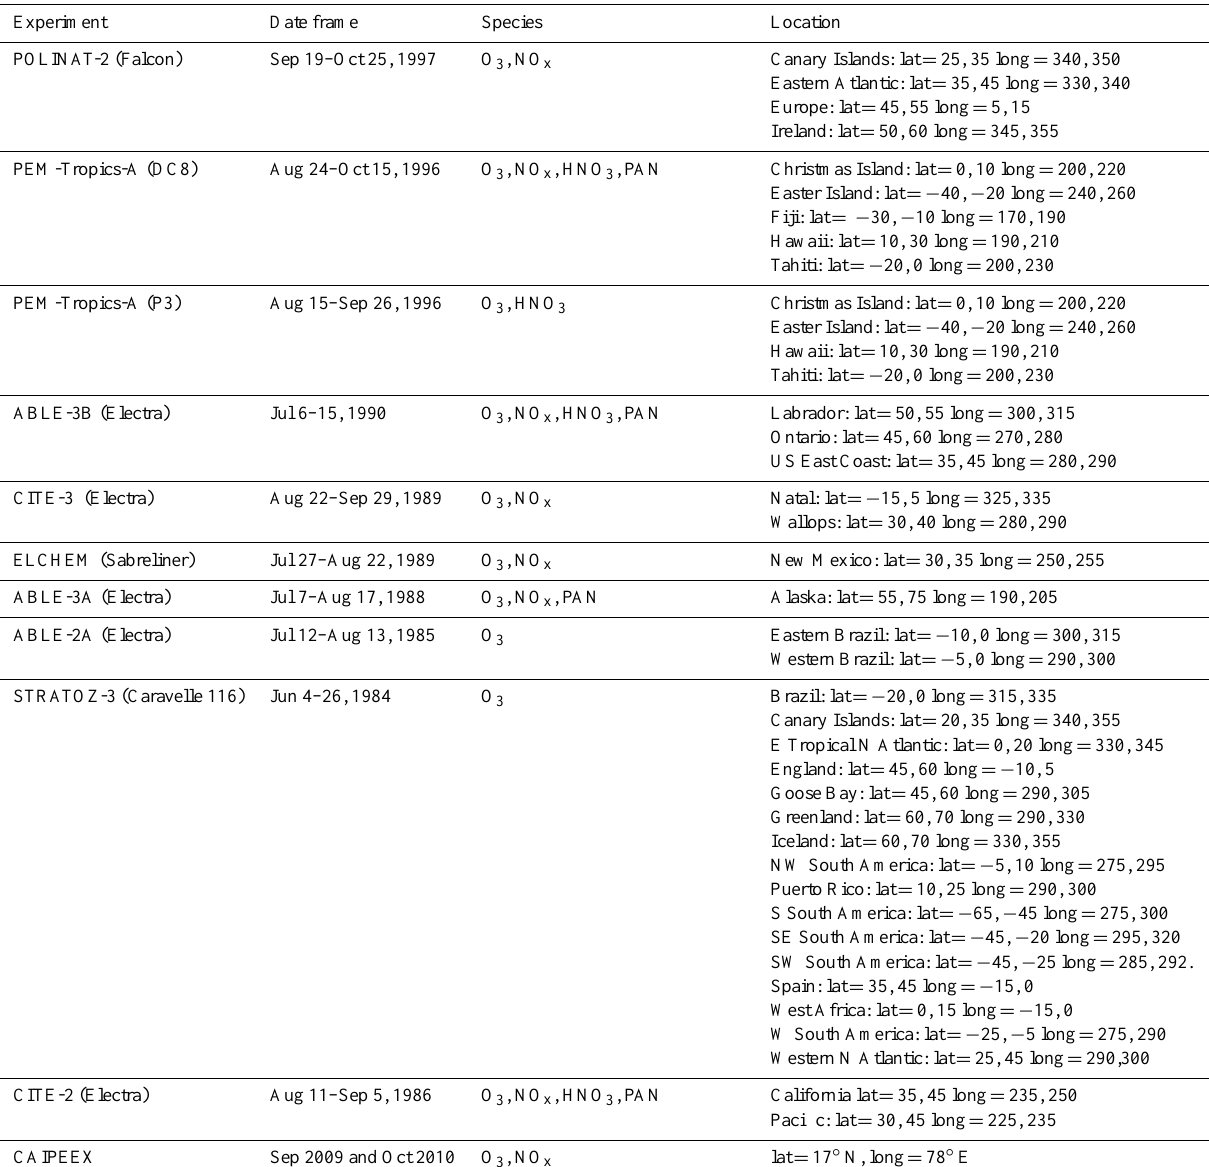
Table 1. Global aircraft measurements used for model